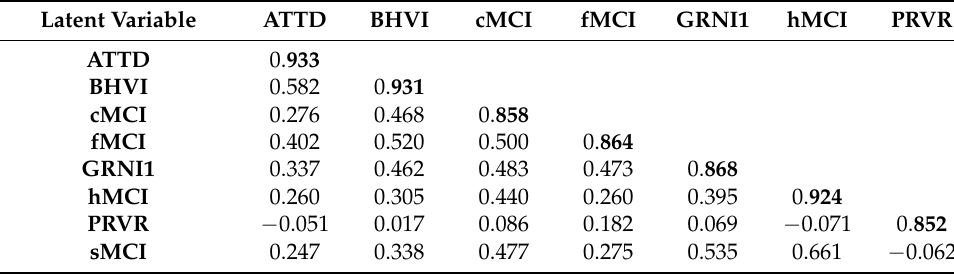
Table 5. Discriminant validity (Fornell–Larcker criterion). Latent Variable ATTD